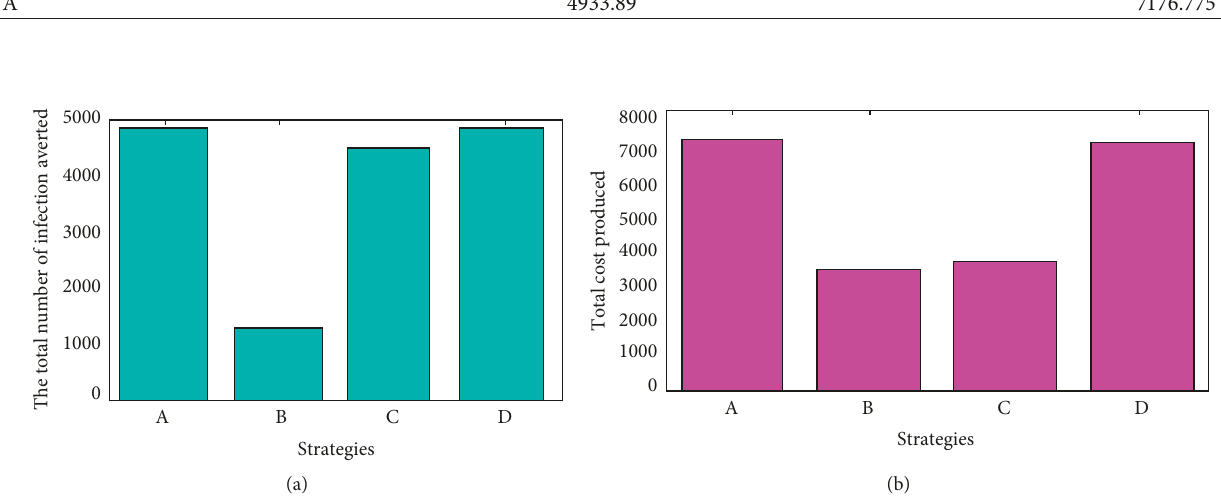
Figure 9: Total infectious averted and the objective functional plot indicating the effect of each control strategy.